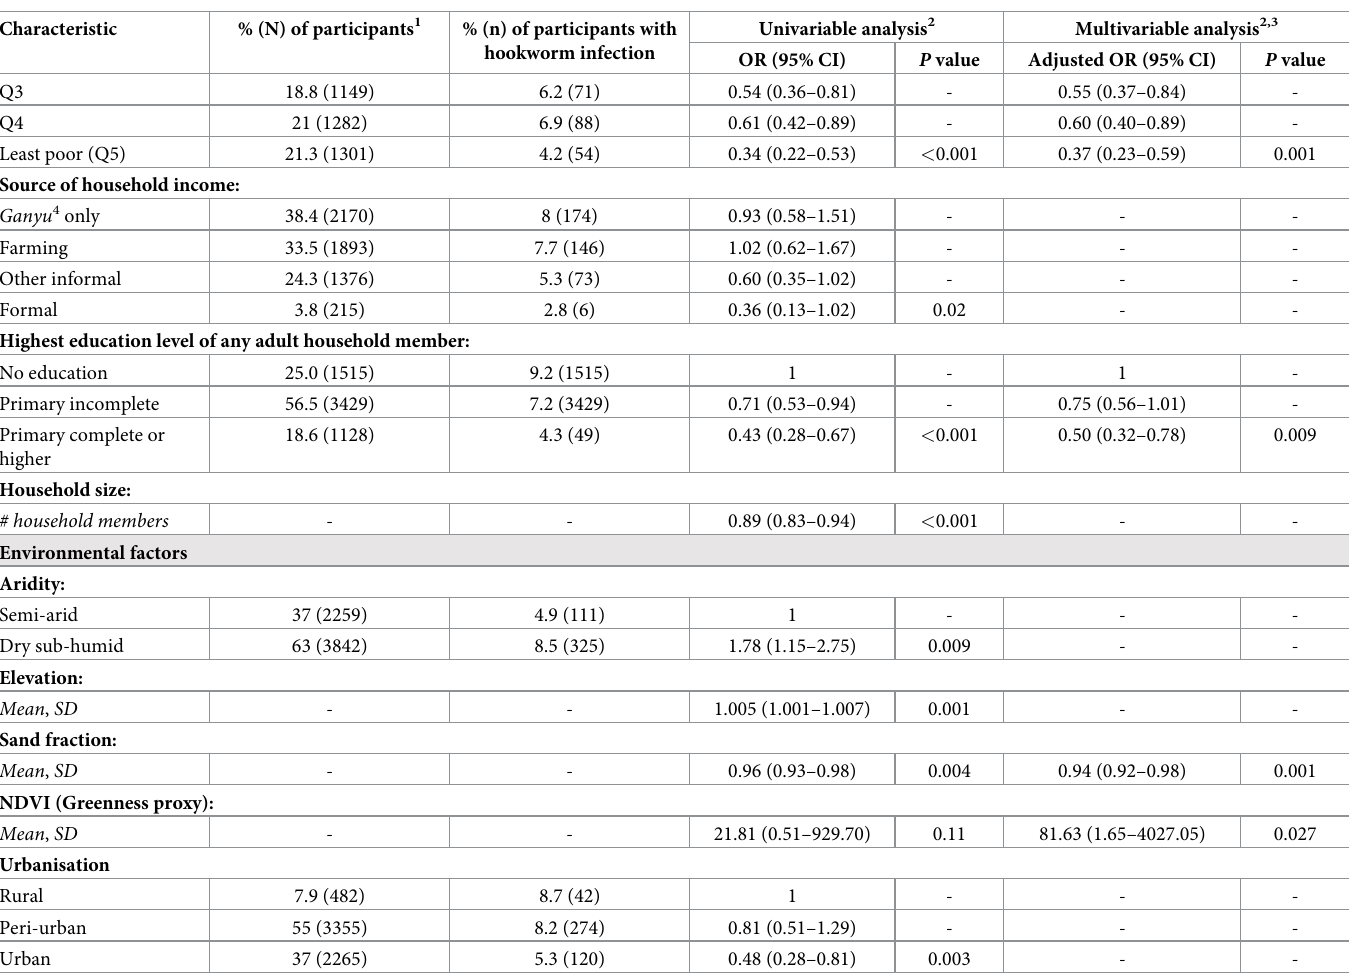
prevalence of 1.6% (95% CI 1.3–2.0%). Infection with S . mansoni was detected in 32 of the 40 study clusters, with similar infection prevalence observed in males (1.5%) and females (1.7%). Other infections detected were Enterobius vermicularis (0.6%, n = 37, in 25 clusters) and Hymenolepis nana ( < 0.1%, n = 4, observed in 3